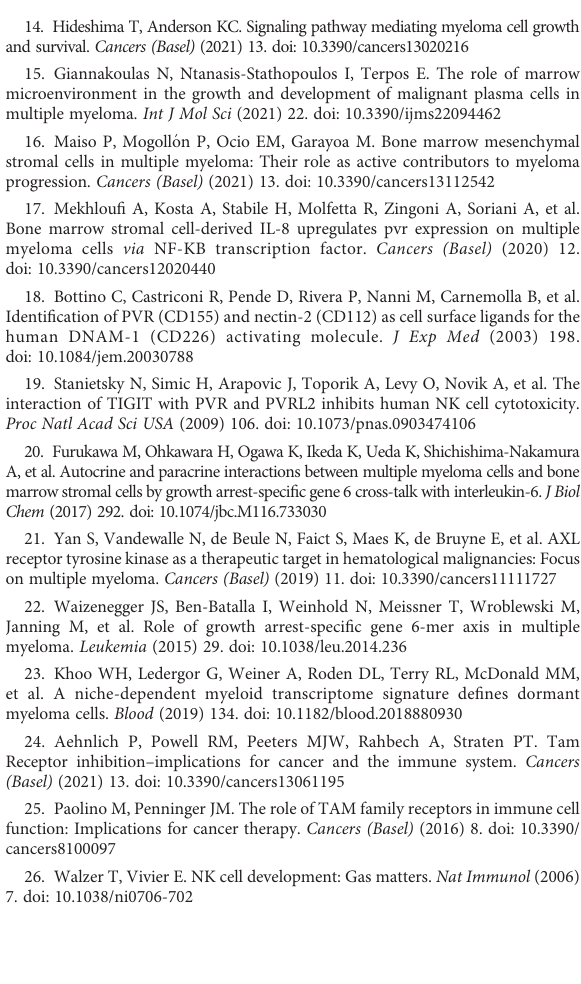
SUPPLEMENTARY TABLE 2 Clinical parameters of MM patients used for the analysis of MICA surface expression and mRNA. Patients were classi fi ed according to Durie and Salmon ’ s Staging